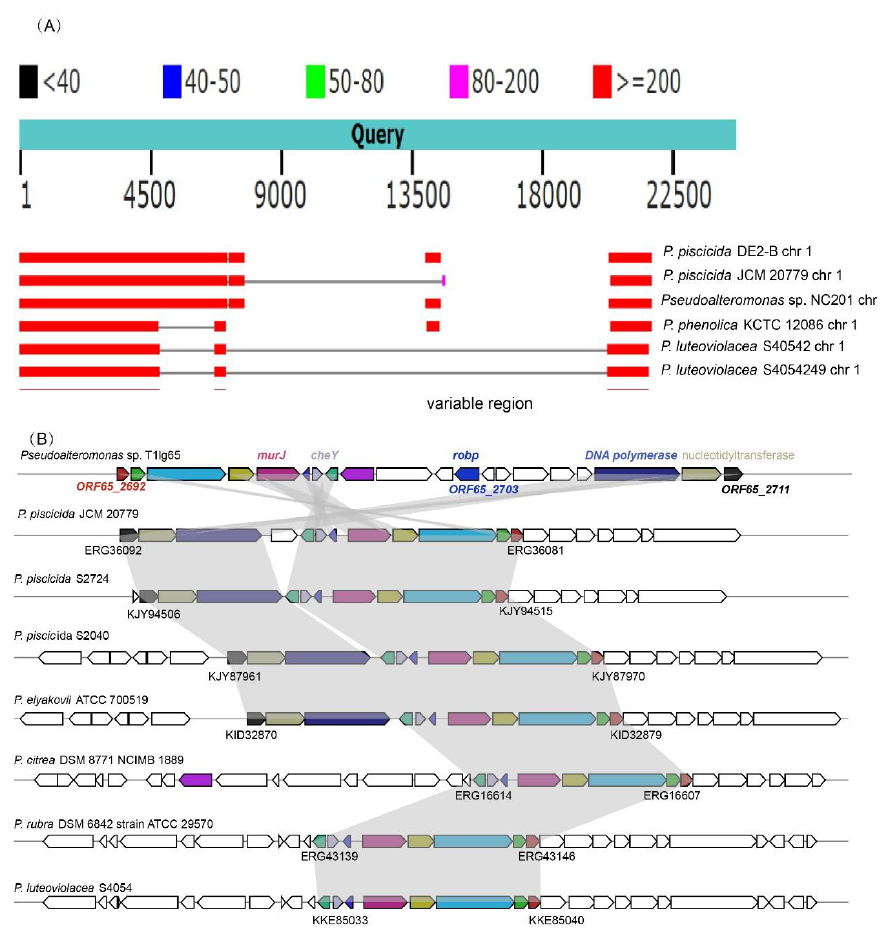
Figure 4. Region of genomic plasticity in the context of robp . ( A ) NCBI-BLAST outputs against RefSeq-archived sequences as of Jan, 2018 suggest that robp and neighboring genes could constitute a candidate genetic region of variability in Pseudoalteromonas strains, but its up-/down-stream genomic surroundings are comparably conserved; ( B ) The synteny alignment scheme indicates that robp is located in a region of genomic plasticity, indicating robp and its vicinity acquired by isolate T1lg65 are probably resulted from a series of genomic transposition and rearrangement. Genes coding for DNA polymerase, nucleotidyltransferase and Chemotaxis Y (CheY) protein are found to exist immediately adjacent to the ‘ robp island’. Schematic diagrams of robp and its vicinity are drawn to scale.